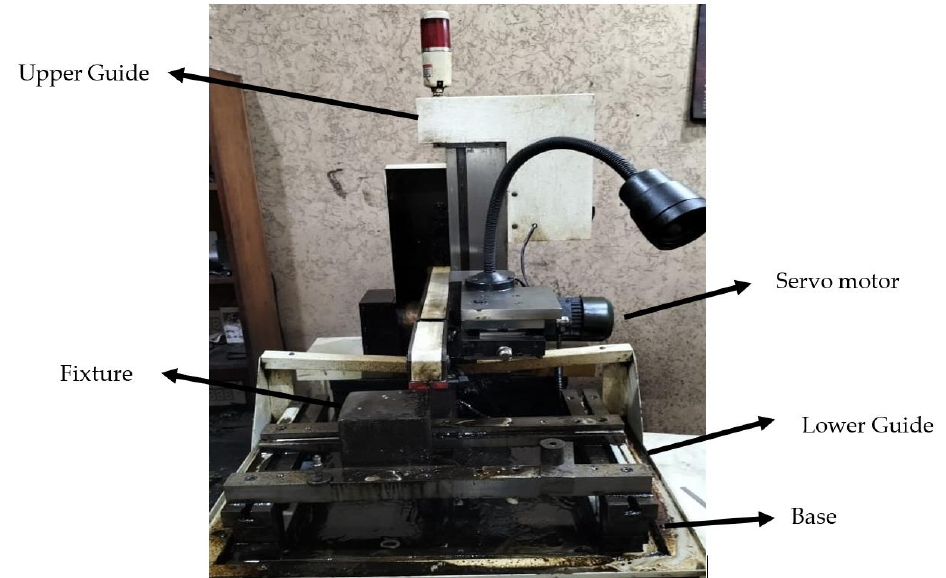
Figure 2. Wire cut electric discharge digital control machine — DK7725.